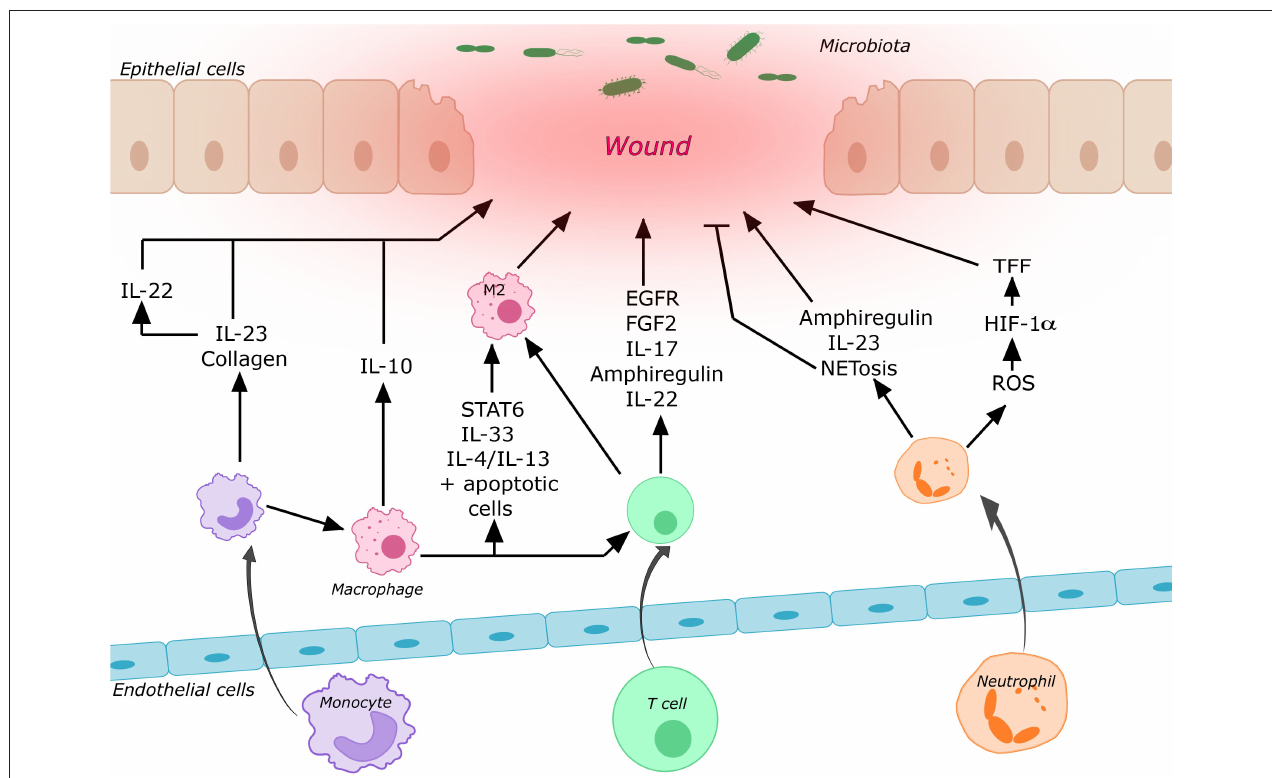
FIGURE 1 | Contribution of some of the most important immune cells to intestinal wound healing. Circulating immune cells are recruited to the wound area by cell trafficking processes. After entering the tissue these cells may undergo differentiation processes and secrete various mediators, which promote or repress mucosal wound healing (for details cf. main